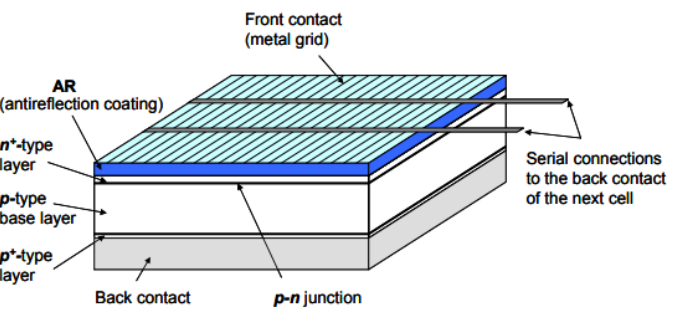
Figure 1. Structure of a c-Si solar cell